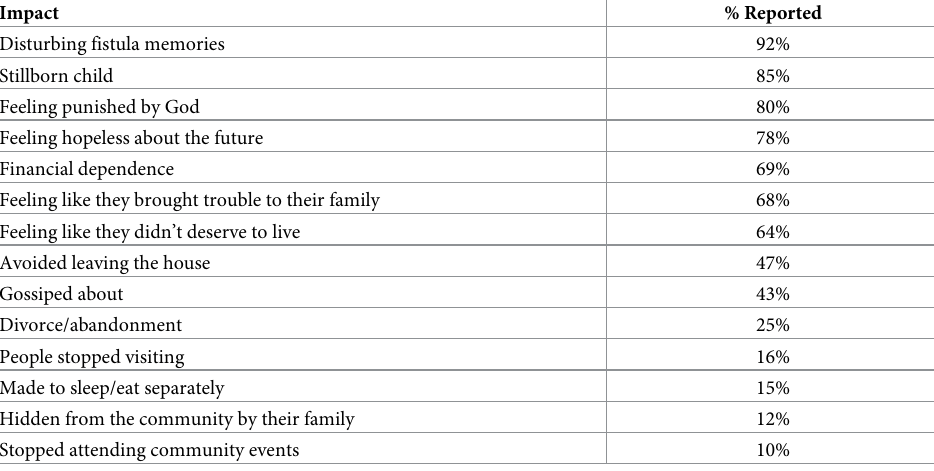
Table 4. Endorsement of fistula impacts (n =